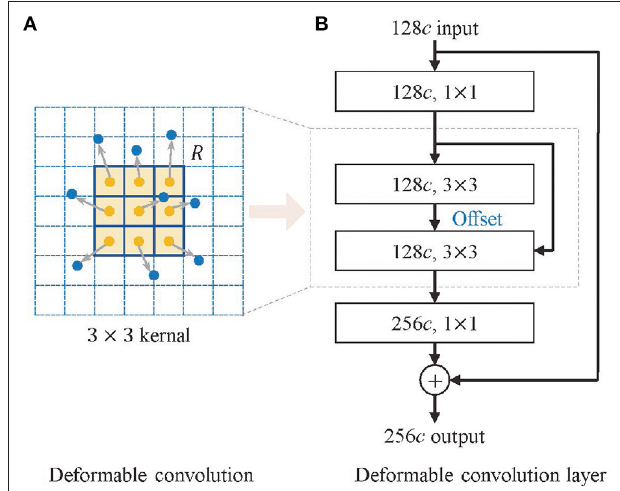
FIGURE 3 | Structure of deformable convolution module. (A) The deformable convolution and (B) the deformable convolution